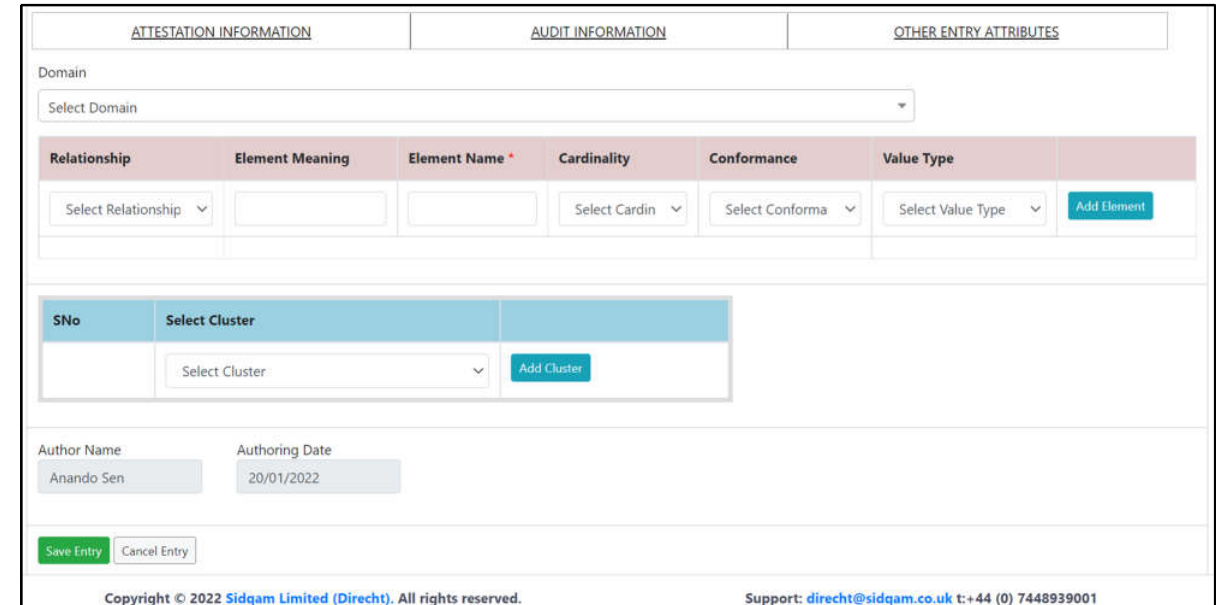
Figure 4. Image showing the ‘Element’ section in an ‘Entry’ page in Direcht.